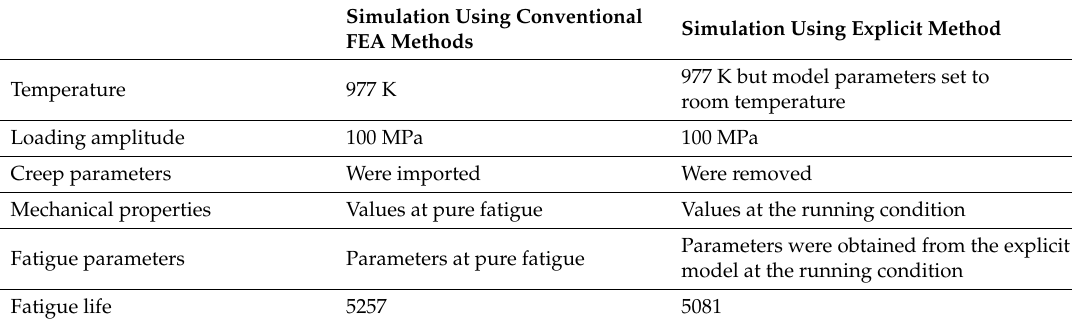
Figure A3. Fatigue life obtained at the pure-fatigue condition using explicit method. This example is also summarised in Table A1. Table A1. Fatigue evaluation by FEA.